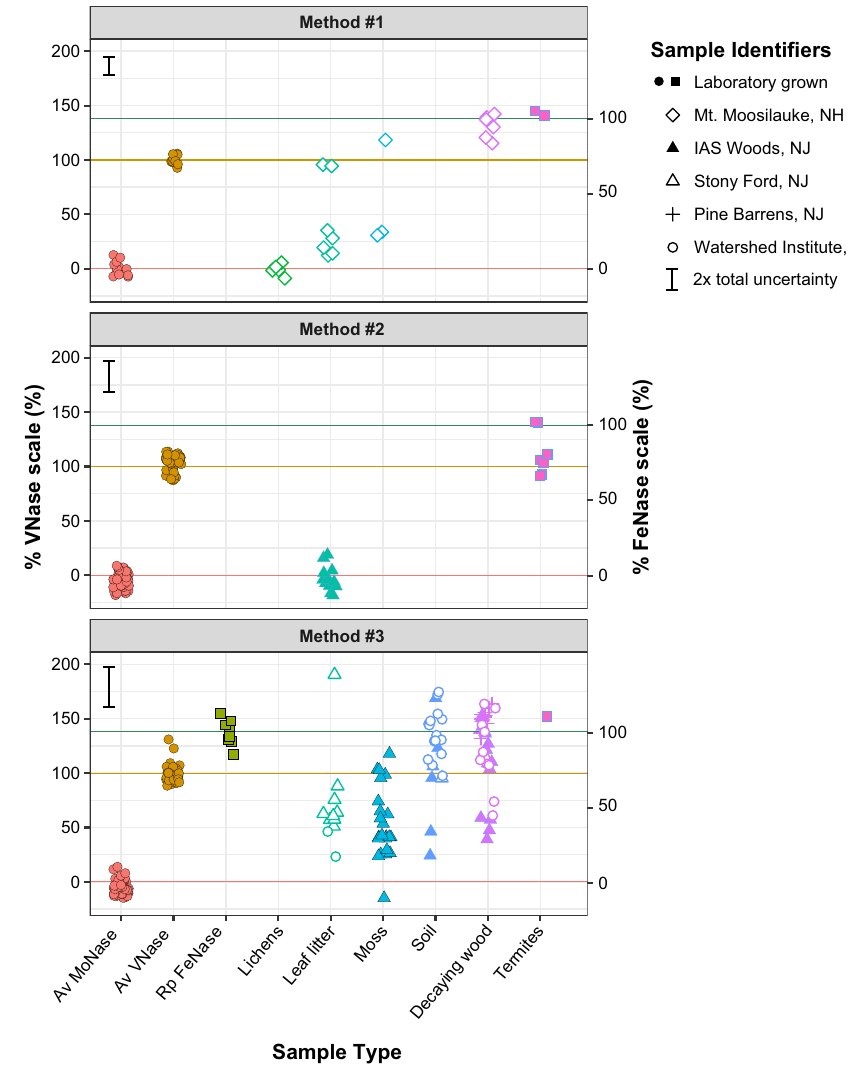
Figure 3. Complementary nitrogenase contribution to acetylene reduction (as %VNase or %FeNase) within ARAs on environmental samples with low BNF activity and single nitrogenase utilizing diazotroph cultures. Sample summary statistics (Avg ± s.d. %VNase, Range %VNase, no. samples): Leaf litter (32.4% ± 45.4%, − 19.9 to 195.4%, 30), Lichens (− 0.8% ± 4.7%, − 8.9 to 5.6%, 6), Moss (65.3% ± 37.9%, − 14.5 to 123.0%, 31), Soil (123.9% ± 37.2%, 25.4 to 177.8%, 21), Termites (130.1% ± 22.0%, 104.8 to 156.6%, 7), and Decaying wood (125.9% ± 32.6%, 40.6 to 167.6%, 43). Abbreviations are as follows: Av MoNase – Azotobacter vinelandii MoNase strain, Av VNase – A. vinelandii VNase strain, and Rp FeNase – Rhodopseudomonas palustris FeNase strain. See Supplementary Methods S5 and S6, and Supplementary Data S1 online for details of scaling and uncertainty